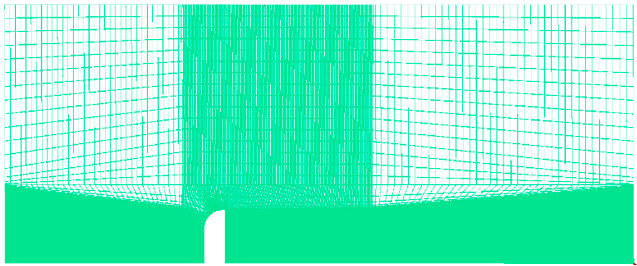
Figure 6. Compressible computing mesh generation.